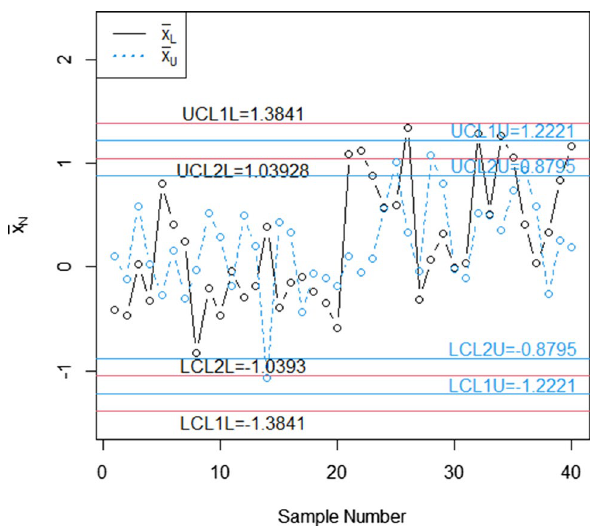
Fig. 2 The control chart proposed by [30] for the simulated data